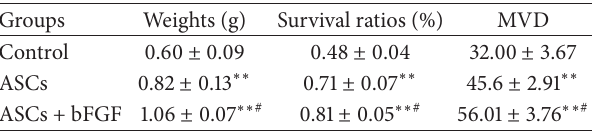
Table 1: Evaluate the weight, survival, and MVD in different fat